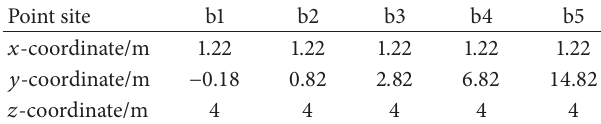
Figure 16: Comparison of the SPL values at vertical evaluation points for the two pantograph opening orientations. Table 5: The coordinates of each noise evaluation